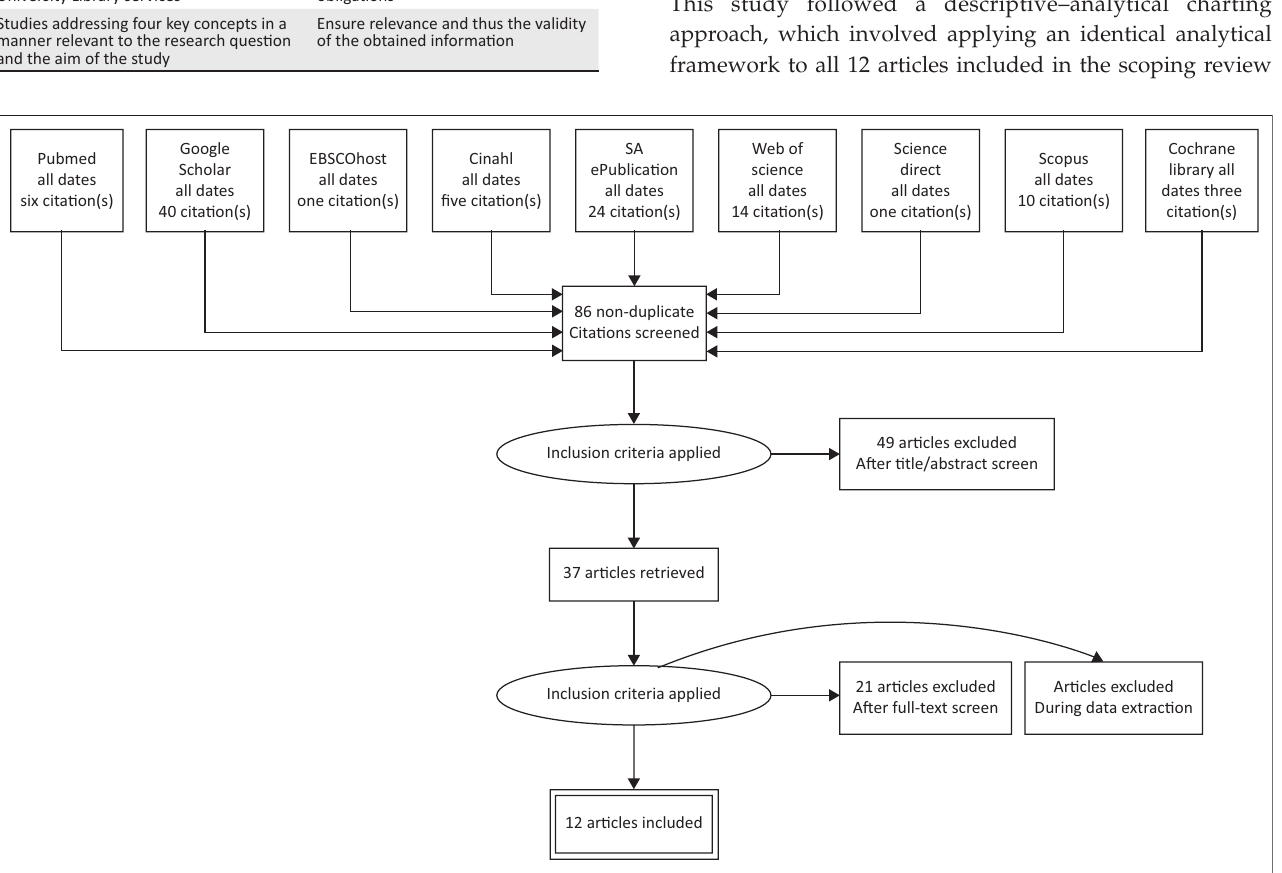
FIGURE 2: PRISMA diagram representing the number of articles found in each